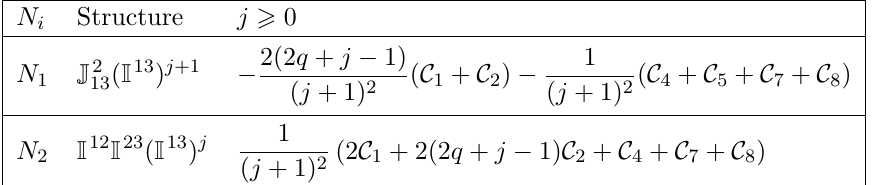
Table 15 . Expansion of the supersymmetric correlator in the component has spin (0 ; 1 ( j + 1)) and QO has spin ( 1 2 setting the absent coe(cid:14)cients to zero (see caption of table 2).